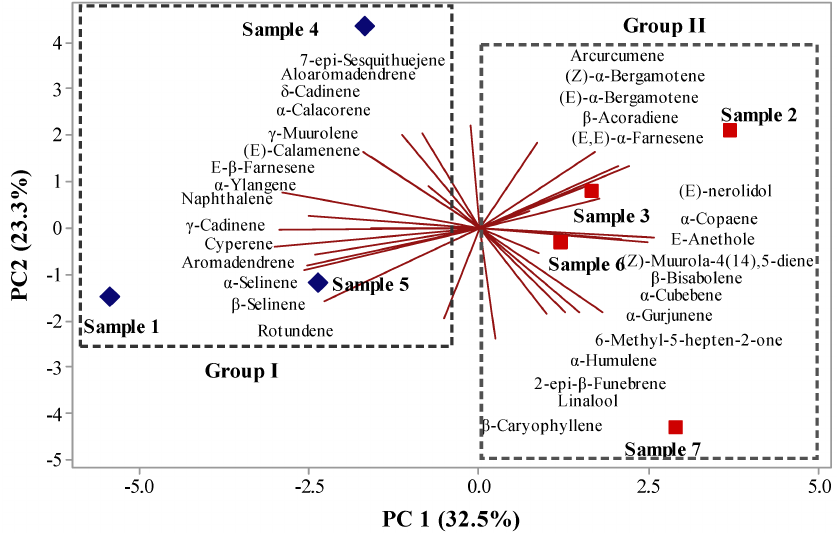
Figure 3. Biplot (PCA) from the analysis of volatile compounds identified in the aromas of seven samples of bee propolis from Apis mellifera